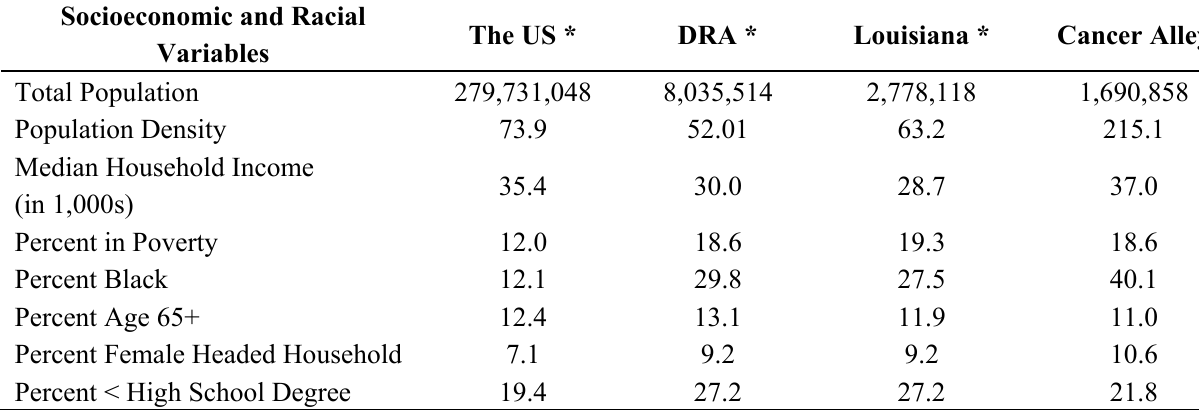
Table A1. Descriptive statistics of socioeconomic and racial variables at the national, Delta Region Authority (DRA), Louisiana state and Cancer Alley levels.